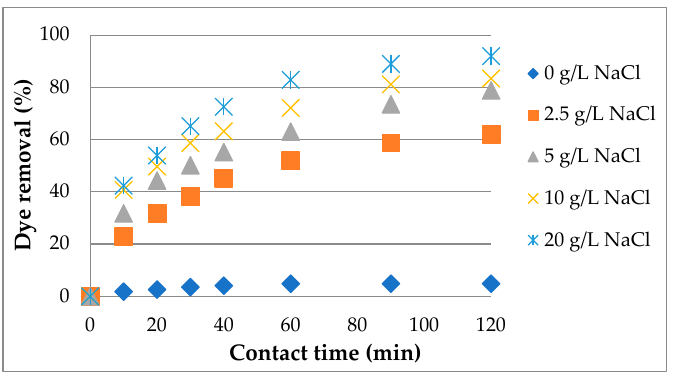
Figure 4. Influence of concentration of sodium chloride (NaCl) on dye removal on S5 rice husk (adsorption conditions are 0.1 g/L Congo red, 25 °C, 10 g/L rice husk).